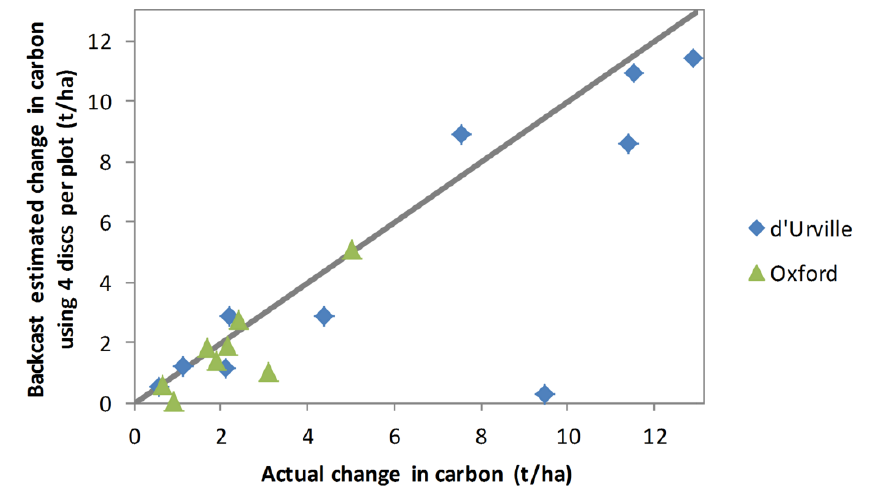
Figure 9. Backcast estimated 2008–2012 change in carbon using 4 discs per plot versus actual change in carbon. Values shown are plot means. The line indicates the y = x